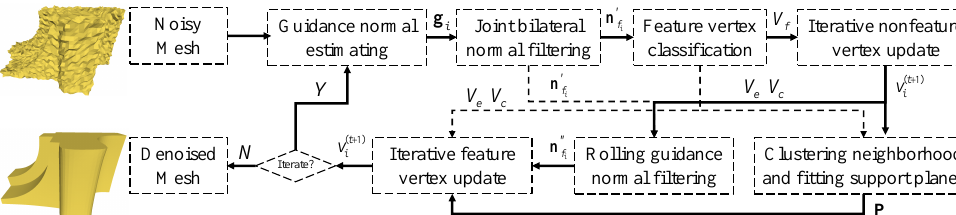
Figure 1. Flowchart of our